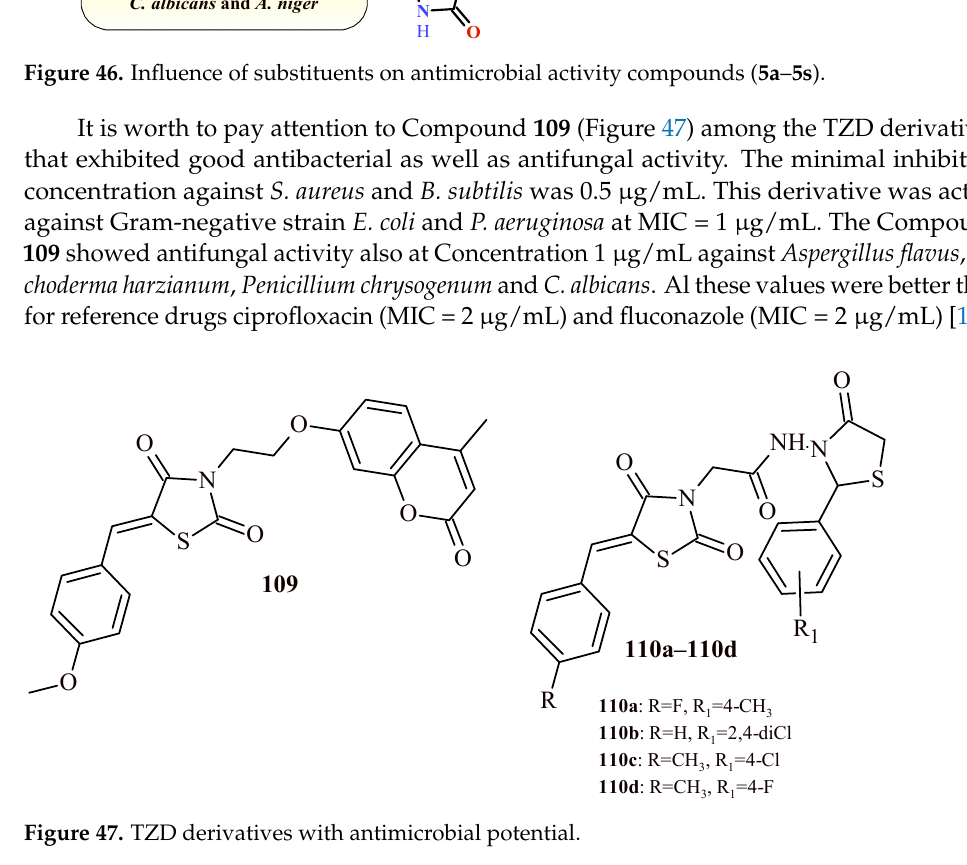
Figure 47. TZD derivatives with antimicrobial potential.